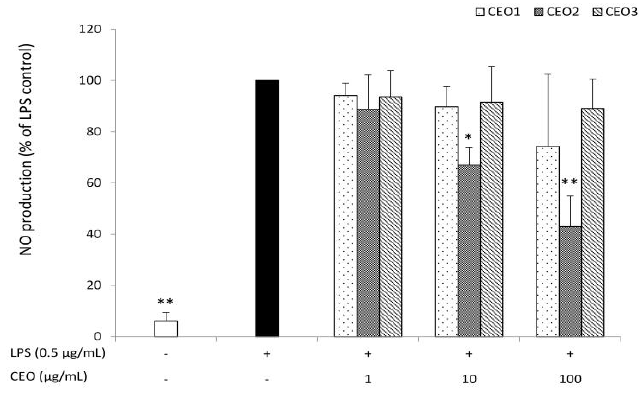
Figure 2. Effect of chinotto essential oils at different ripening stages [CEO1 (green), CEO2 (half ripe), and CEO3 (ripe)] on nitric oxide (NO) production by lipopolysaccharide (LPS)-stimulated RAW264.7 macrophages. Cells were seeded in 96-well plates at a density of 2.5 × 10 5 cells mL −1 and, after overnight incubation, were treated with LPS (0.5 μg mL −1 ) and with (or without) increasing concentrations of CEOs for 48h. The supernatants of the cells were analysed for nitrite production by the Griess method. Data are presented as percentages and LPS control (without CEOs) was fixed at 100%. The average absolute nitrite value for the LPS control was approximately 40 μM. Values represent the mean of three independent experiments (each done in duplicate) ± standard deviation. Mean value was statistically different from control (* p < 0.05, and ** p < 0.01).